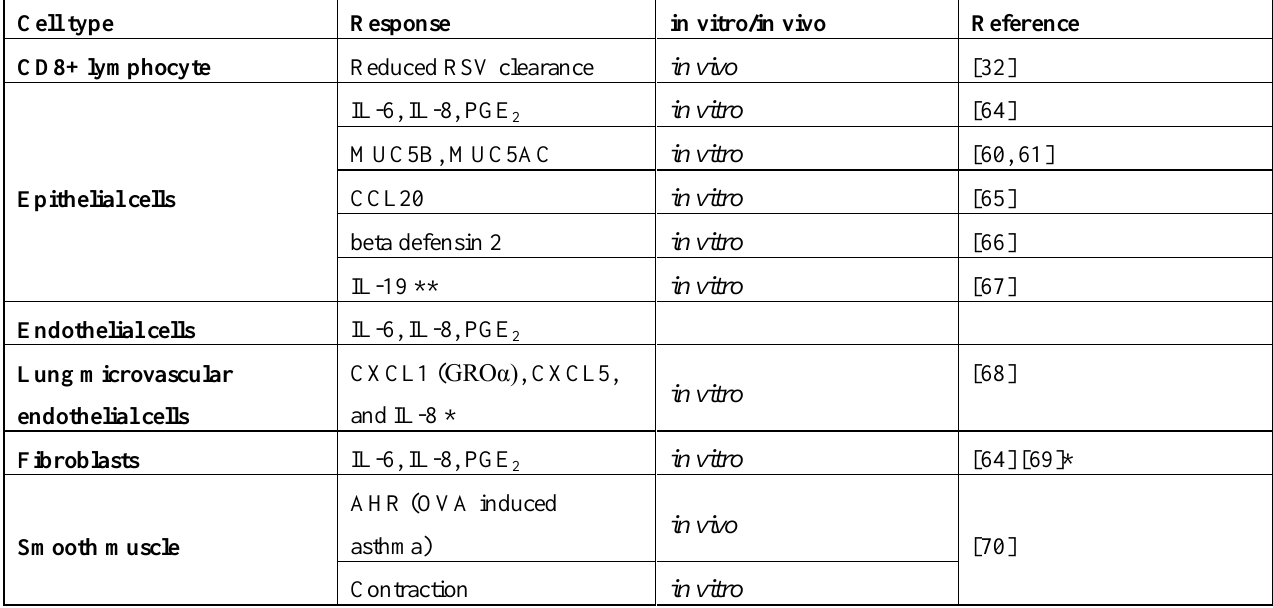
Table 1. Responses and products released by the cells present in the respiratory tract when stimulated with